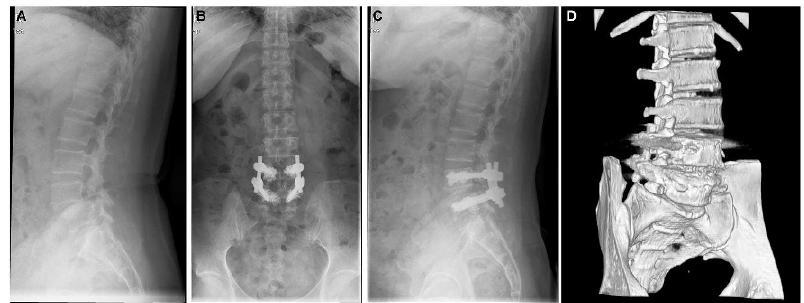
Figure 4 - A: A 54-year-old female patient who had a history of back pain for more than five years. The pain was exacerbated after a trauma four months before presentation and she was diagnosed with L4 spondylolisthesis. B and C: The patient underwent internal fixation and transforaminal lumbar interbody fusion. All screws used for augmentation were CICPS. Eight months after surgery, x-ray images showed that the spine reduction was sustained. No screws were loosened or pulled out. Three-dimensional CT images showed that bone fusion had already been achieved